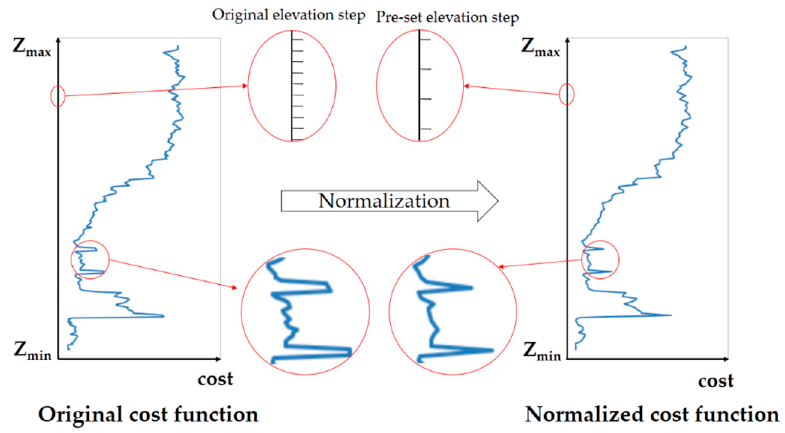
Figure 5. Normalization of the cost function which has a smaller step than the pre-set value. 2.2. Initial DSM Generation with Semi-Global Aggregation Semi-global cost aggregation is originally used in binocular stereo matching [2]. The semi-global aggregation function is given by 1-D energy function with piecewise smooth constraint. As shown in Figure 6, pixel-wise cost is aggregated for each pixel from at least eight directions independently. Then, optimal disparity of each point is obtained by the WTA principle.